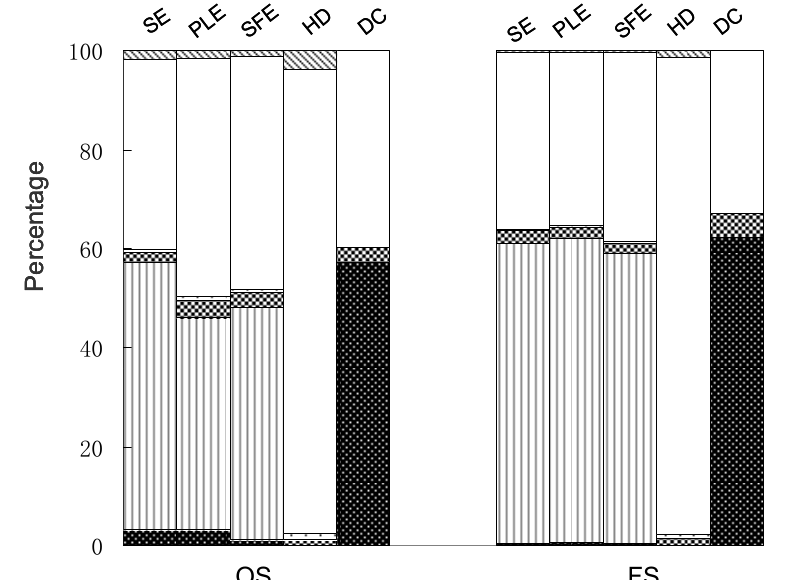
Figure 4. Comparison of six investigated compounds in different extracts from Angelica sinensis (old stock sample (OS) and fresh sample (FS)) extracted by sonication extraction (SE), pressurized liquid extraction (PLE), supercritical fluid extraction (SFE), hydrodistillation (HD) and decoction